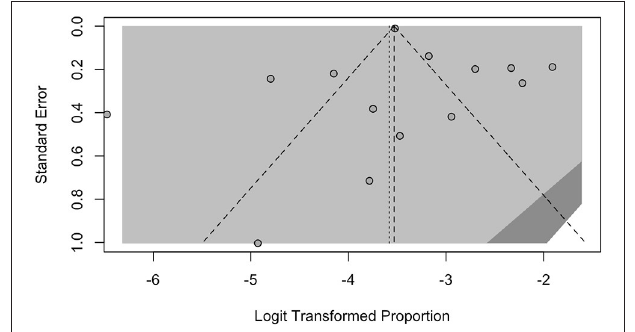
FIGURE 4 | Border-enhanced funnel plots for all studies included in the meta-analysis.